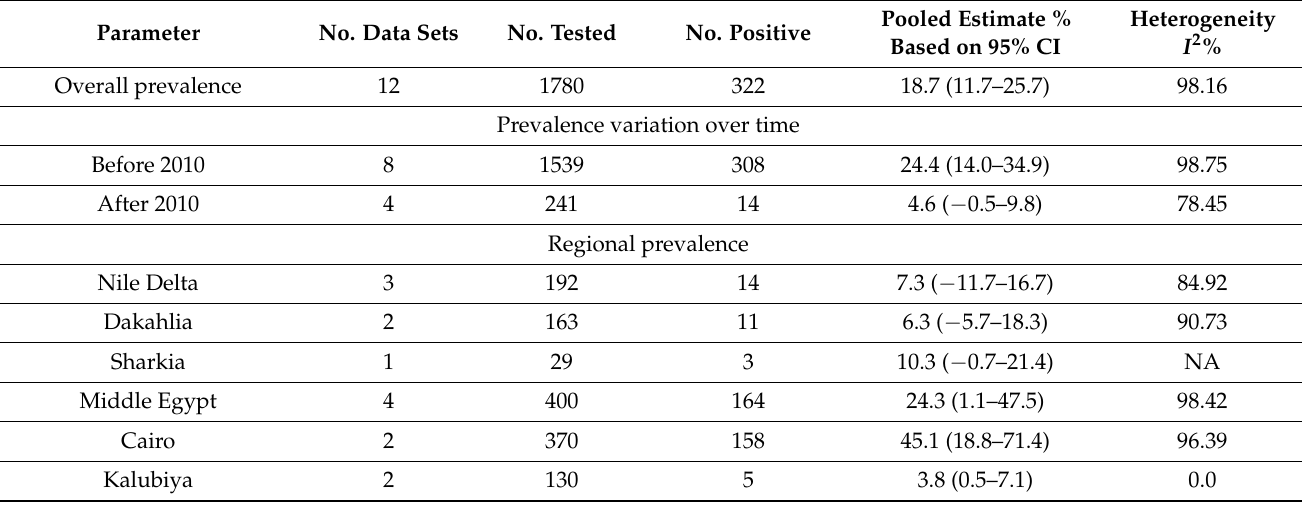
Table 9. Overall and regional prevalence of Heterophyes heterophyes detected in dogs from various Egyptian regions, and variabilities according to dog life